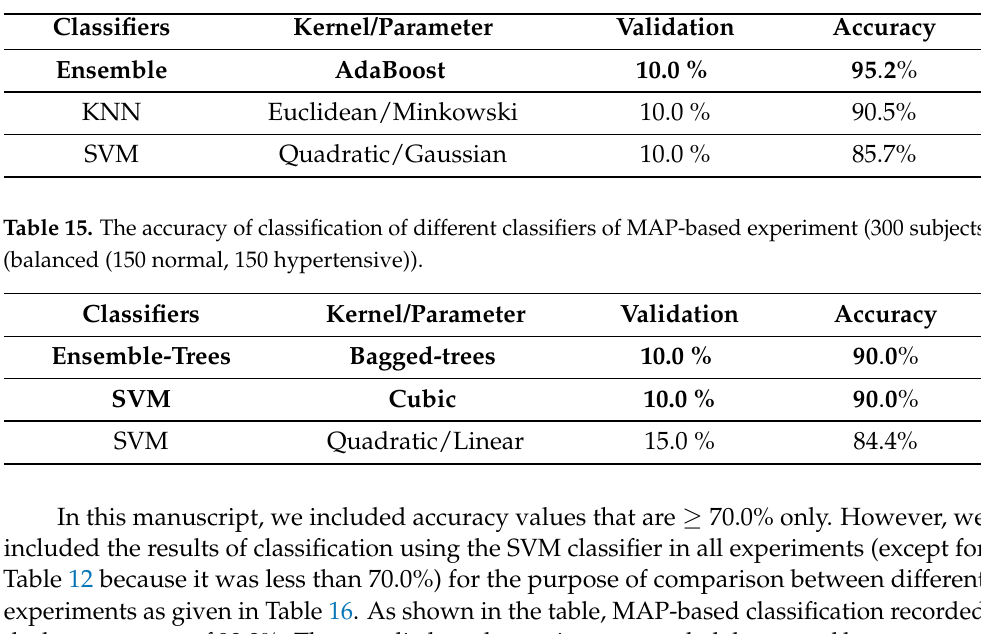
Table 14. The accuracy of classification of different classifiers of MAP-based experiment (214 subjects (balanced (107 normal, 107 hypertensive)).